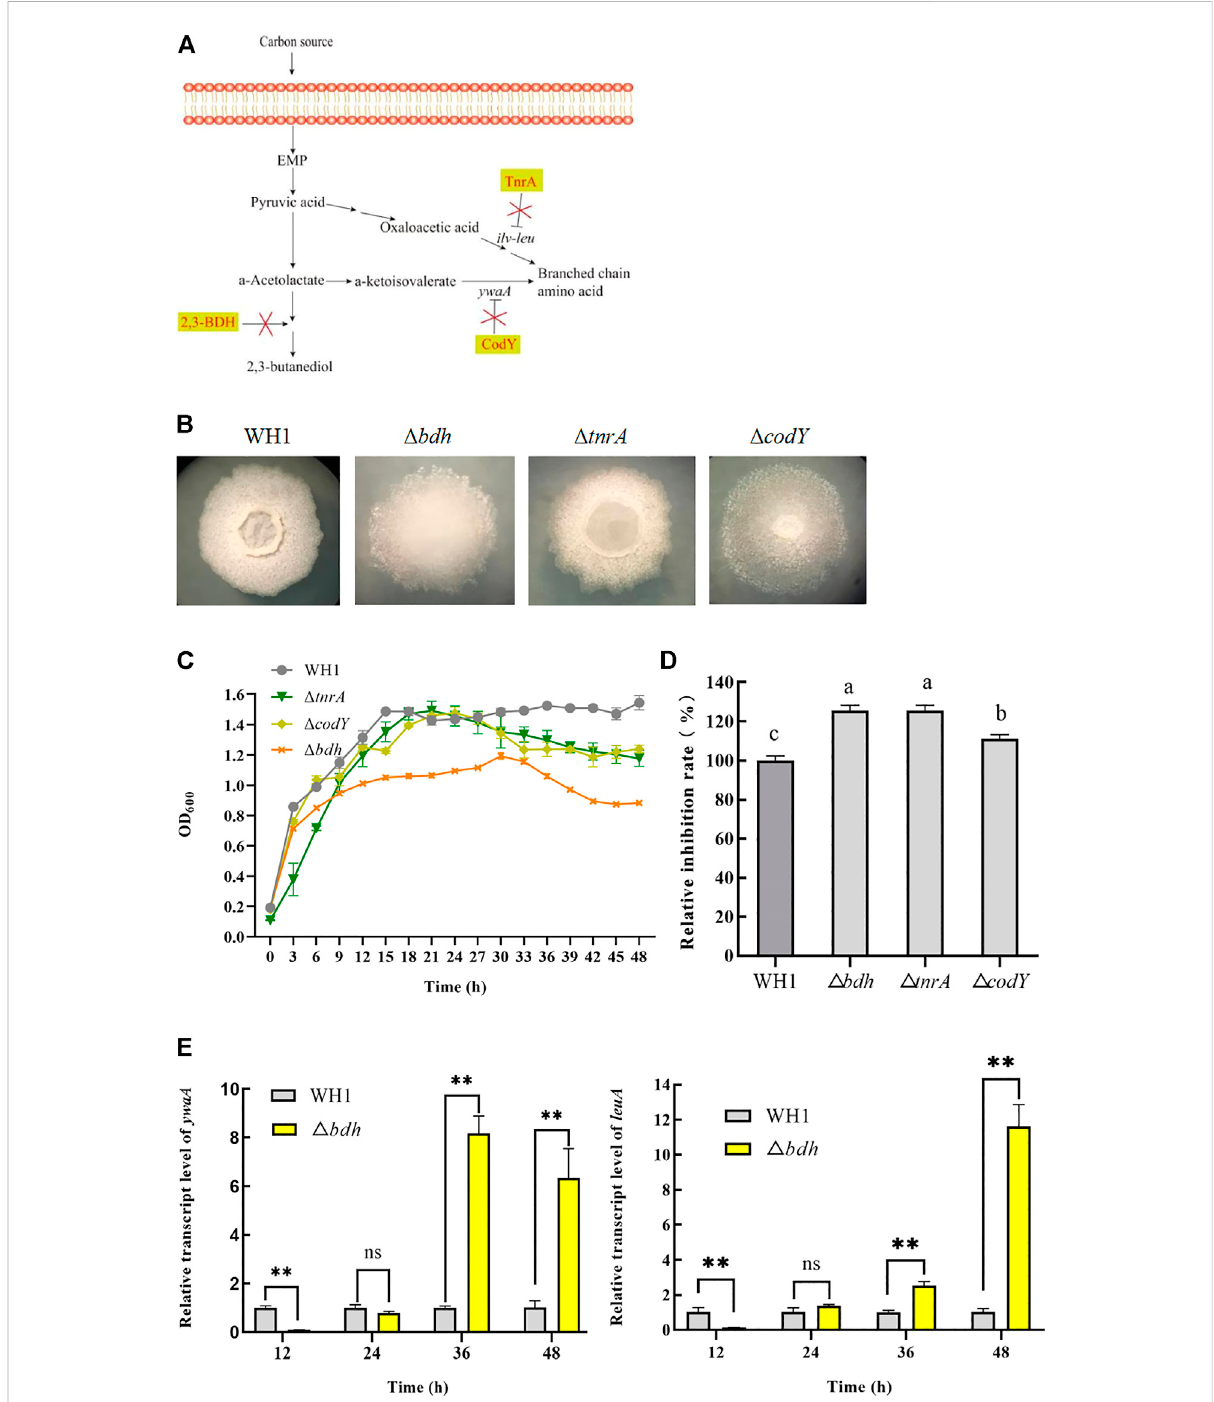
FIGURE 2 Relative inhibition rates and characteristic of knockout strains related with biosynthesis of branched-chain amino acids. (A) : Metabolic pathway andregulationofcarbonover fl owmetabolismandbiosynthesisofbranched-chainaminoacids.2,3-BDH:2,3-butanedioldehydrogenase; TnrAand CodY: regulators for carbon and nitrogen metabolism; ywaA: the aminotransferase gene; ilv - leu : the operon for biosynthesis of branched-chain aminoacids. (B) :Colonymorphology. (C) :Growthcurves. (D) :Relativeinhibitionrates. (E) :Relativetranscriptionlevelof ywaA and leuA in Δ